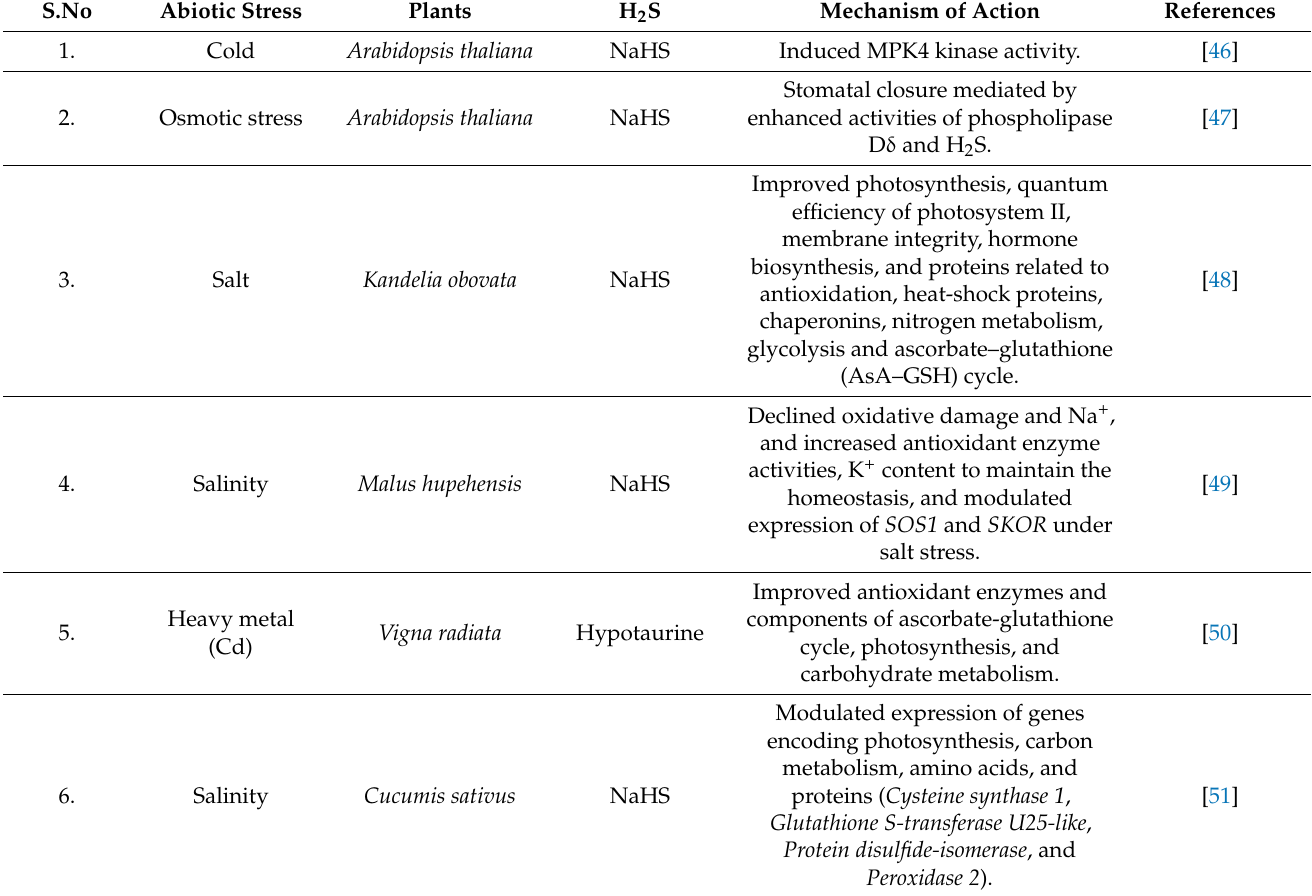
Table 1. Role of H 2 S-mediated abiotic stress tolerance in various